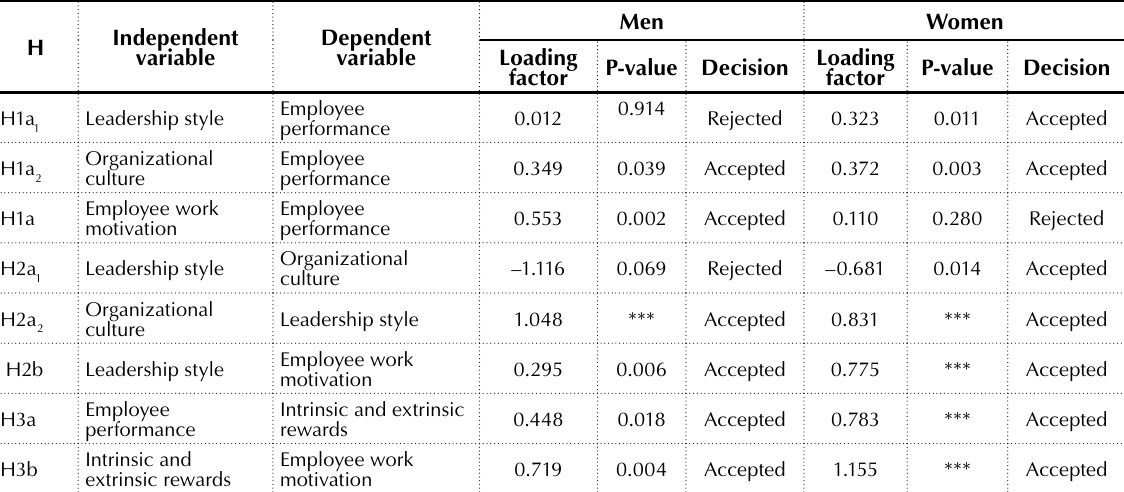
Source: Result processed (2016).